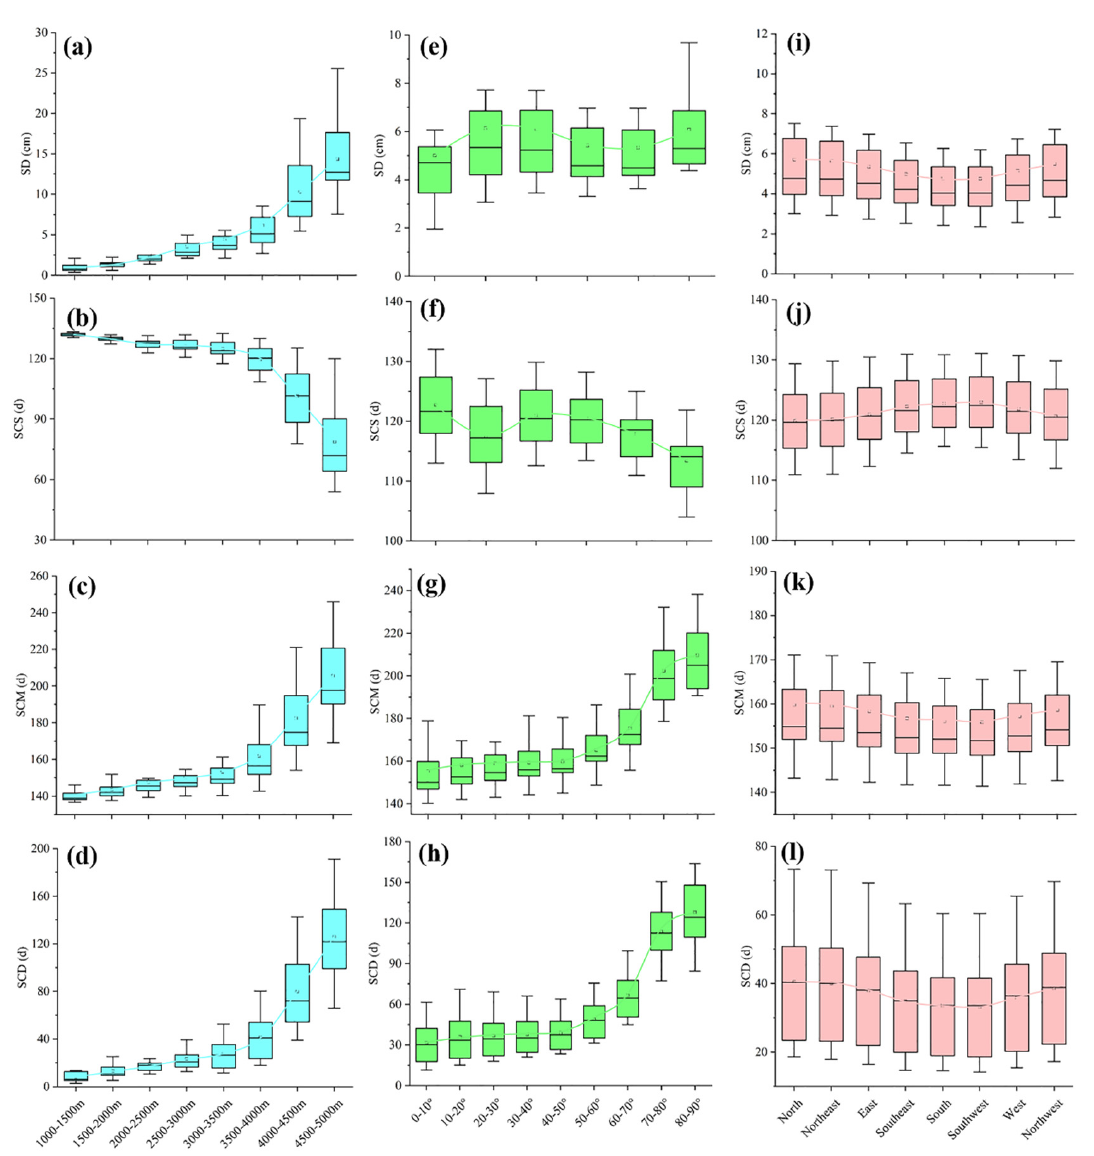
Figure 9. Statistics of LSSP based on terrain. Subplots ( a – d ), ( e – h ) and ( i – l ) correspond to altitude, slope, and aspect, respectively.